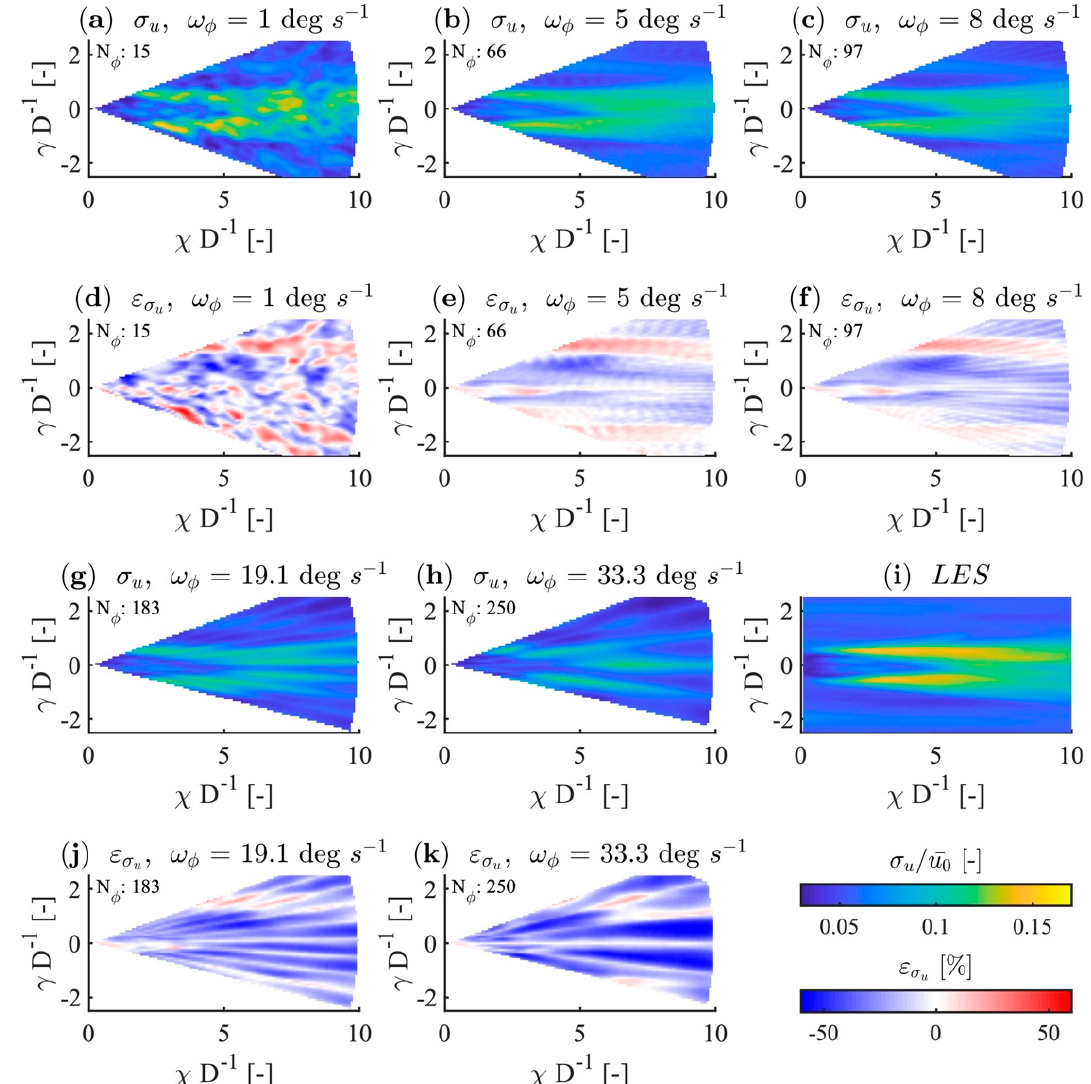
Figure 8. ( a – c , g , h ) Visualisation of the normalised 10-min standard deviation ( σ u ) of the wind-speed component ( u ) of the original PPI data and ( d – f , j , k ) the corresponding deviations ( ε σ normalised 10-min standard deviation of the wind-speed component ( u ) in the LES data.